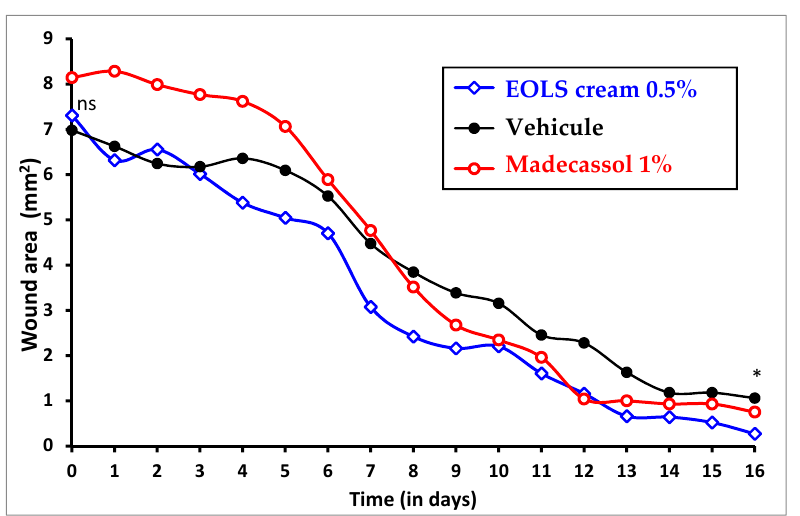
Figure 3. Effect of EOLS cream formulation treatment on wound area (mm 2 ) in rats. * significant difference; ns : not significant.